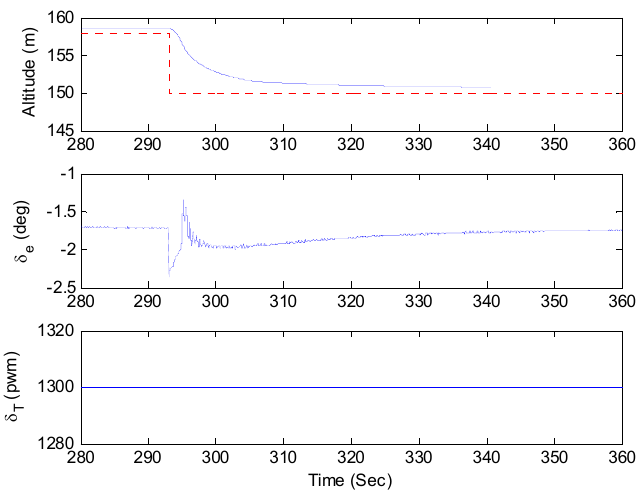
Figure 20. FLC simulation results of descending without the presence of wind.